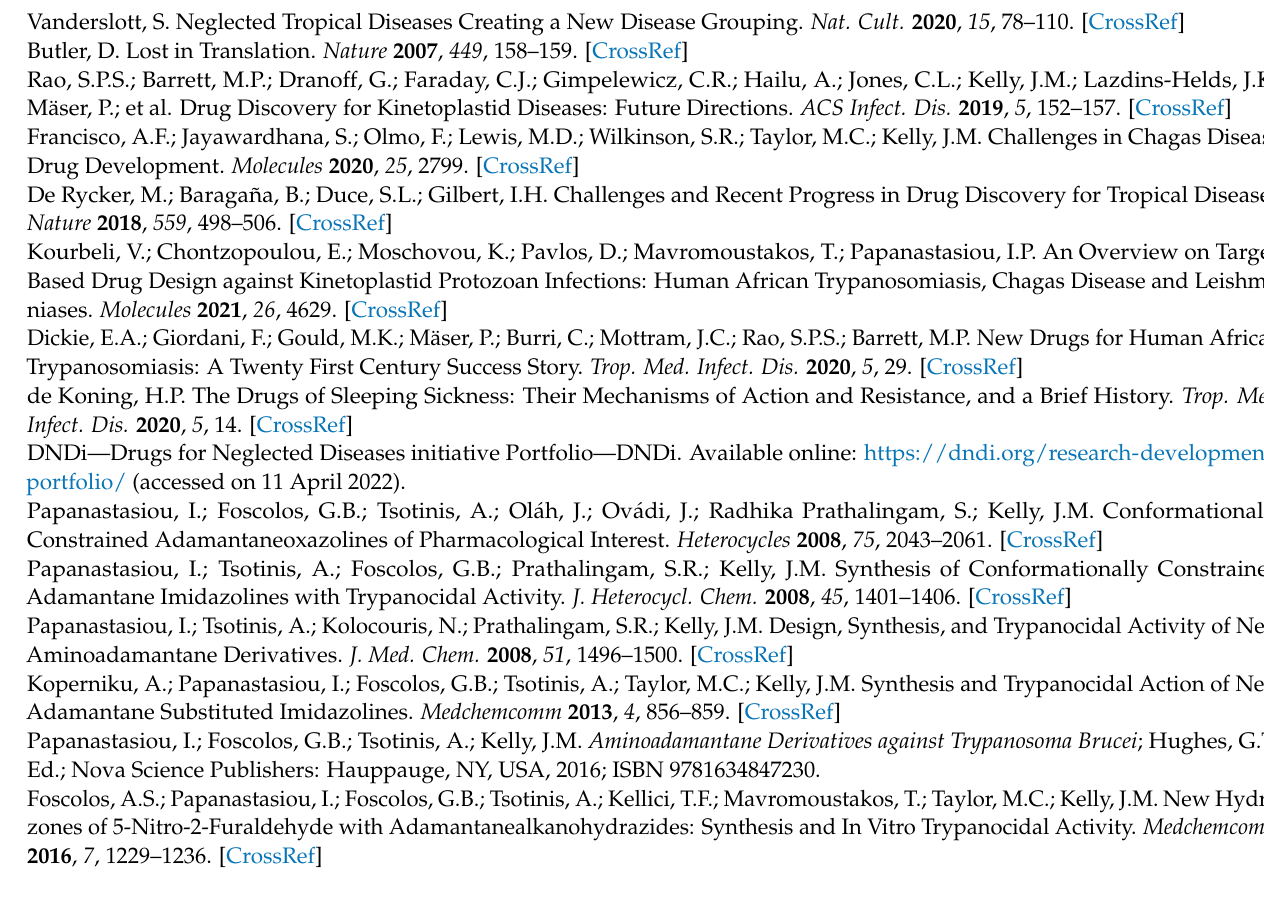
Figure S12: 1 H-NMR spectrum of compound 1c ; Figure S13: 13 C-NMR spectrum of compound 1c ; Figure S14 : IR Spectrum of compound 1c